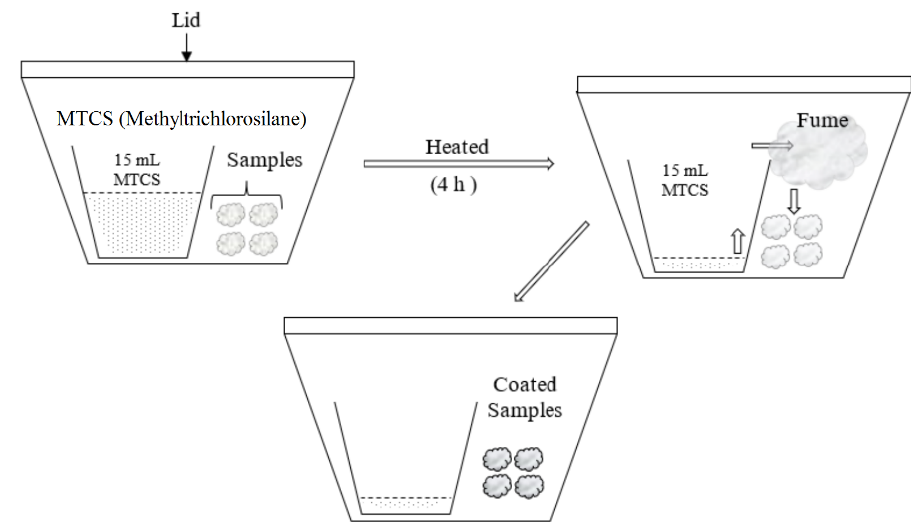
Figure 1. Schematic for the hydrophobic coating process.